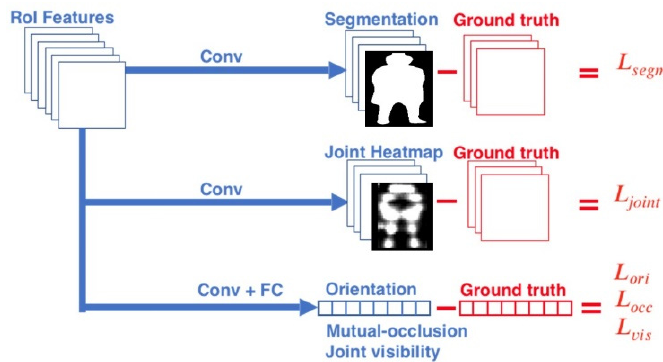
Figure 2. Architecture of the proposed parallel multi ‐ task training network.